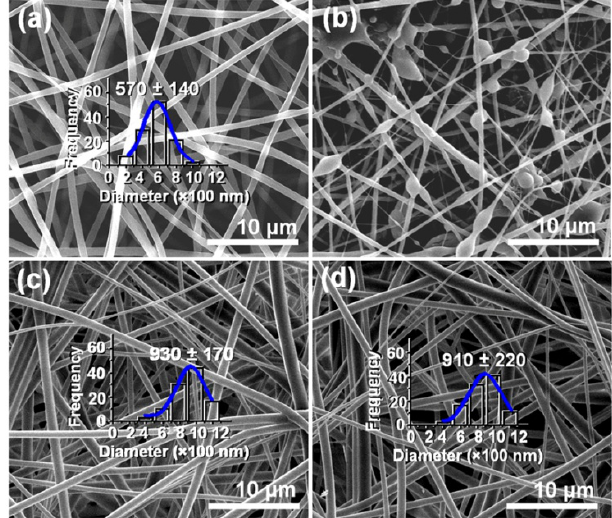
Figure 2. FESEM images of the electrospun nanofibers and their diameter